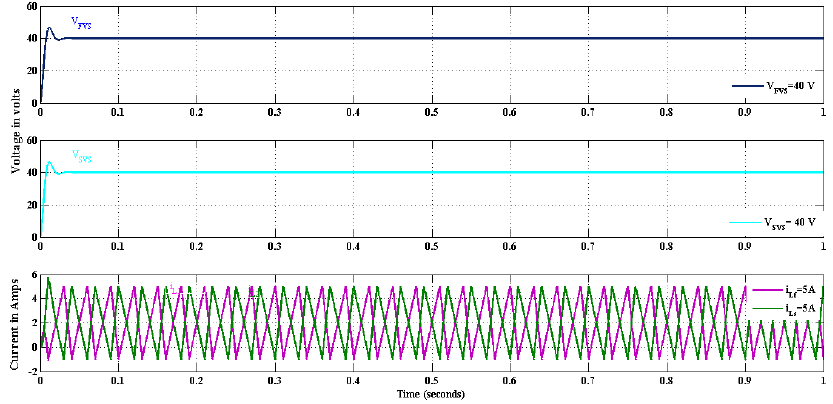
Figure 15. Output voltages and inductor currents in regenerative mode.